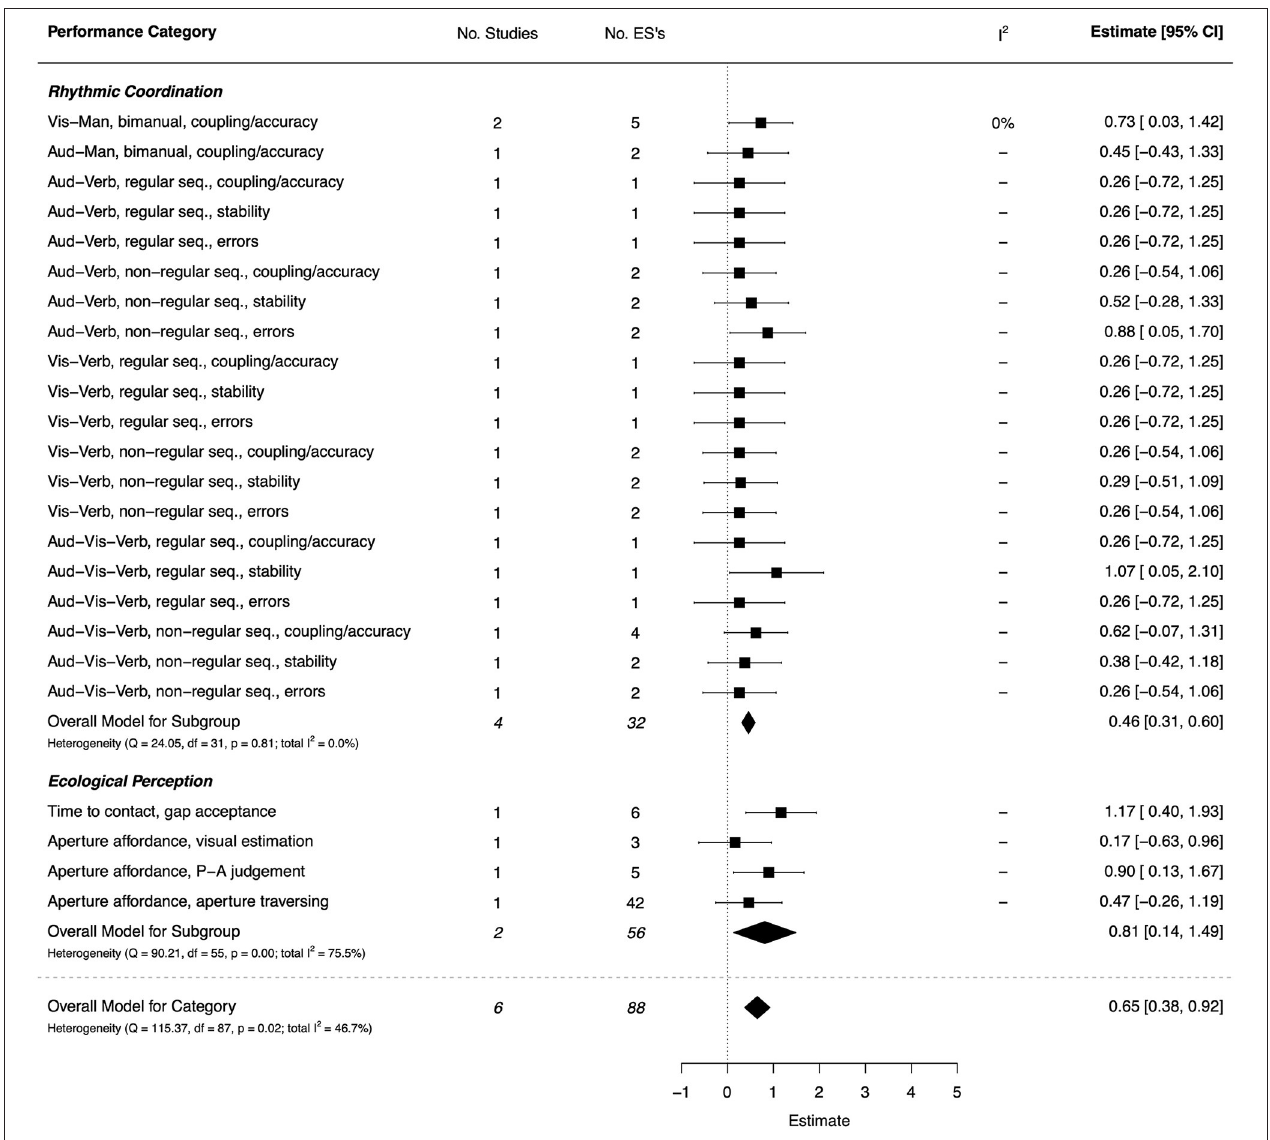
FIGURE 5 | Forest plot showing the meta-analysis results for the dynamical/ecological paradigms performance category. Vis-Man, Visual-Manual; Aud-Man, Auditory-Manual; Aud-Verb, Auditory-Verbal; Vis-Verb, Visual-Verbal; Aud-Vis-Verb, Auditory-Visual-Verbal; Seq., Sequence; P-A, Perception-Action.